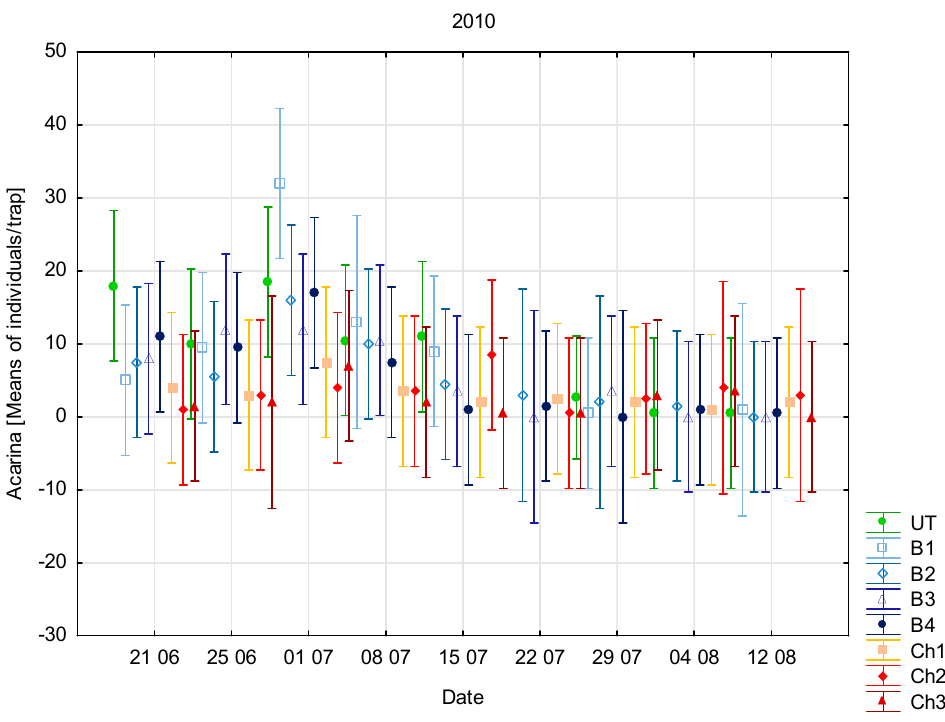
Figure 6. Trapping dynamics of Acarina in broad bean crop in the year 2010: Treatments are the same as in Table 1. Vertical bars denote 0.95 confidence intervals.